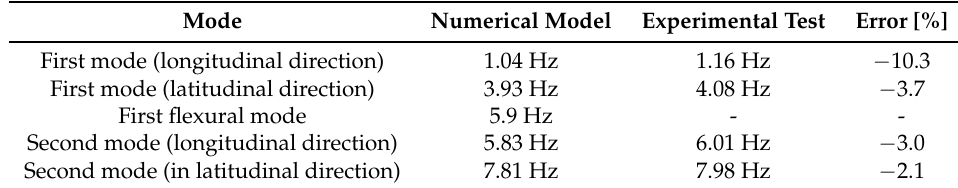
Figure 6. Verification of numerical modeling with experimental test. ( a ) Sensor calibration; ( b ) Sensor placement; ( c ) Sensors in tower. Table 1. Tower’s mode verification